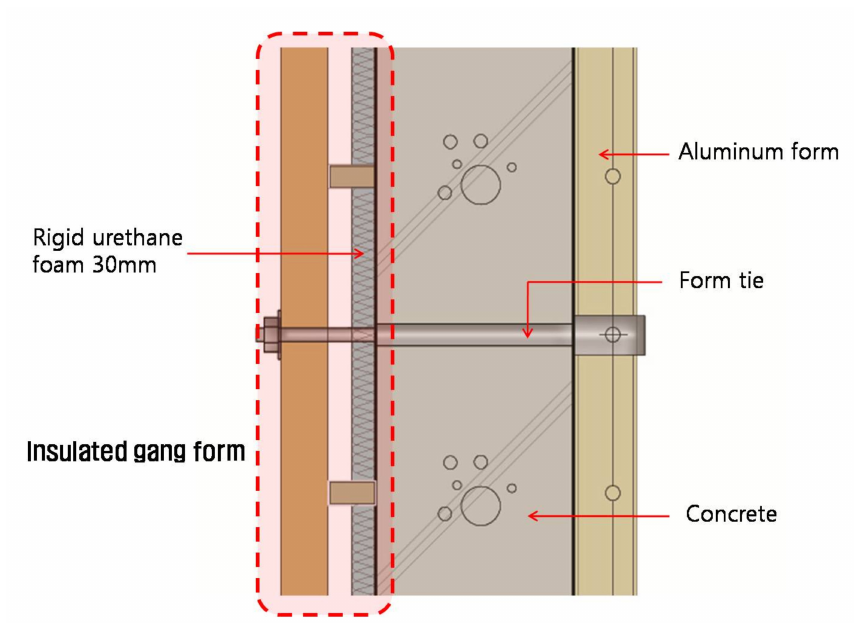
Figure 1. Schematic diagram of the insulated gang form (cross-section).